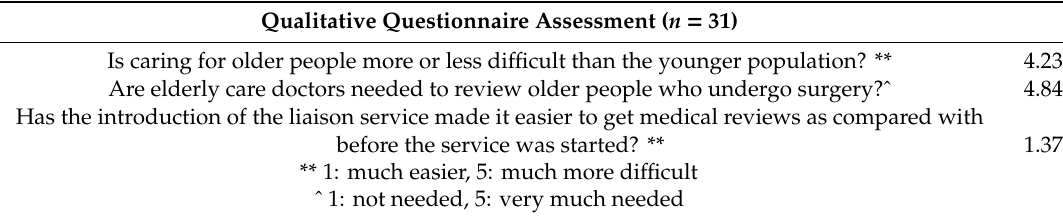
Table 3. Qualitative service